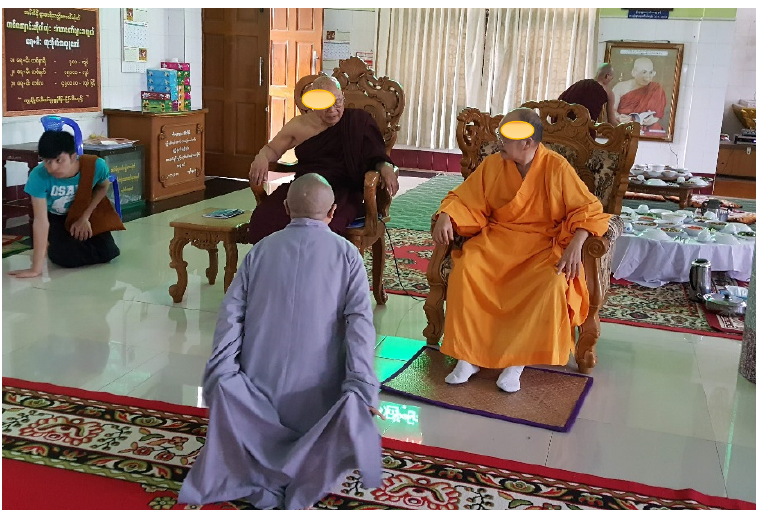
Figure 5. During a lunchtime discussion, two monks sit in chairs while bhik ṣ u ṇ ī Hongxing kneels on